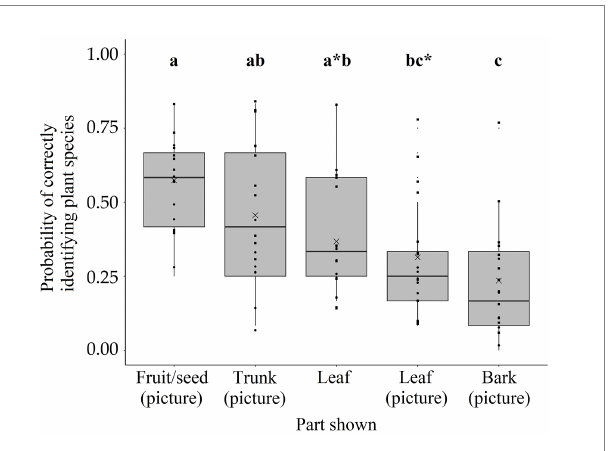
FIGURE 4 Botanical knowledge based on different plant parts. Effect of part shown on the probability of correctly identifying the plant species. Those parts with no corresponding letters indicate statistical significance ( p < 0.05). There was also a trend for the difference between fruit/seed (picture) and leaf and between leaf (picture) and bark (picture) ( p < 0.1), as indicated with an asterisk added to the letter. Data points are indicated with circles for girls and squares for boys. Finally, the mean probability per part shown is indicated with the